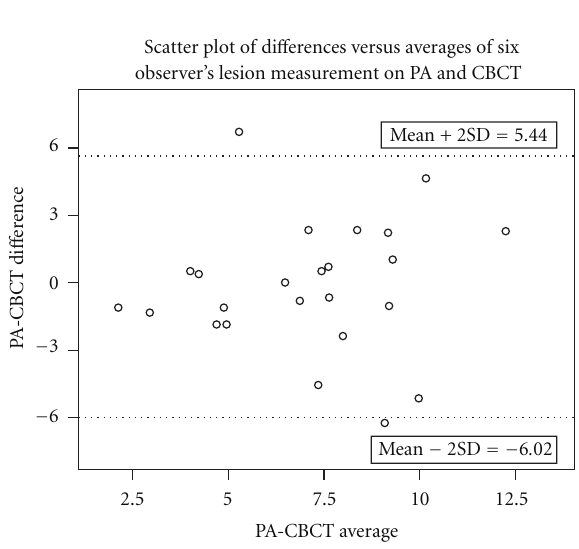
Figure 6: Scatter plot of di ff erences versus averages of six observer’s lesion measurement of PA and CBCT (in